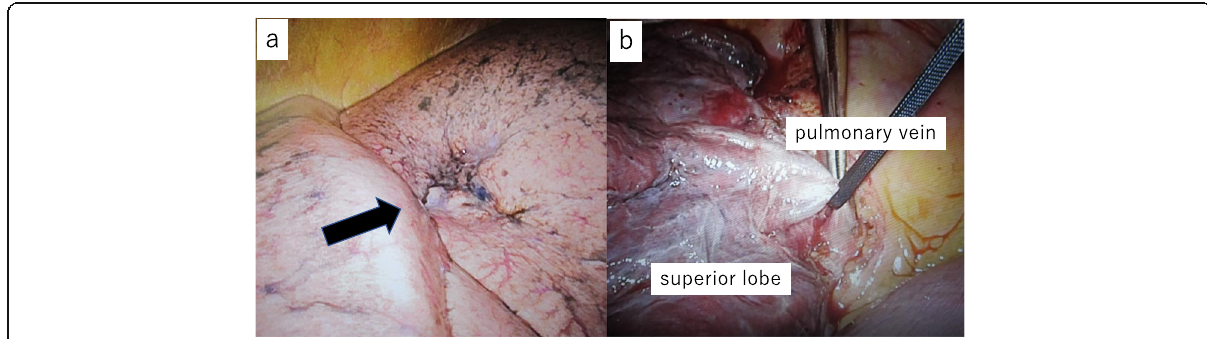
Fig. 3 Thoracoscopic surgery. a The tumor was located in the superior lobe of the right lung (arrow). b Thoracoscopic right lung superior lobe resection was